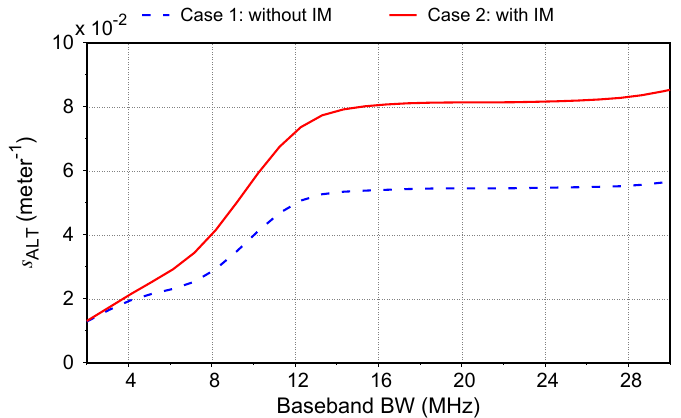
Figure 7. Altimetric sensitivities as a function of baseband bandwidth when considering the IM component. Case 1: without IM, Case 2: with IM.